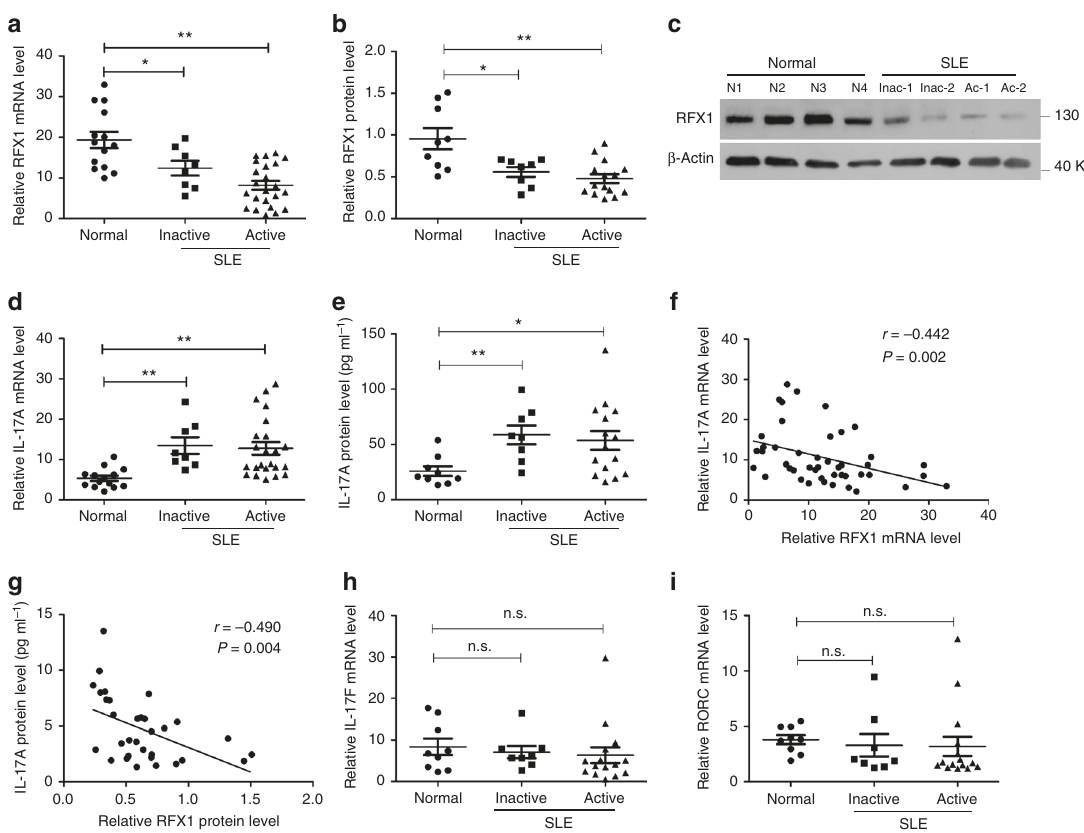
Fig. 1 Decreased RFX1 and increased IL-17A expression in CD4 + T cells of SLE patients. mRNA ( a ) and protein ( b ) expression levels of RFX1 in CD4 + T cells of inactive SLE patients ( n = 8), active SLE patients ( n = 23 for mRNA and n = 15 for protein) and healthy subjects ( n = 14 for mRNA and n = 9 for protein). Representative results of western blot analysis are shown in ( c ). IL-17A mRNA expression level in CD4 + T cells ( d ) and protein level in serum ( e ) of inactive and active SLE patients and healthy subjects. f Correlation between RFX1 and IL-17A at the mRNA level. g Correlation between RFX1 protein levels in CD4 + T cells and IL-17A protein levels in serum. h and i mRNA expression levels of IL-17F and RORC in CD4 + T cells of inactive SLE patients ( n = 8), active SLE patients ( n = 15) and healthy subjects ( n = 9). Small horizontal lines indicate the mean ( ± s.e.m) in a , b , d , e , h , i . * P < 0.05; ** P < 0.01; n.s., not signi fi cant, compared between the indicated groups. Student ’ s t -test (two-tailed) and Mann – Whitney U -test (two-tailed) were used to compare the results. Sperman ’ s correlation coef fi cient was used for the correlation analysis